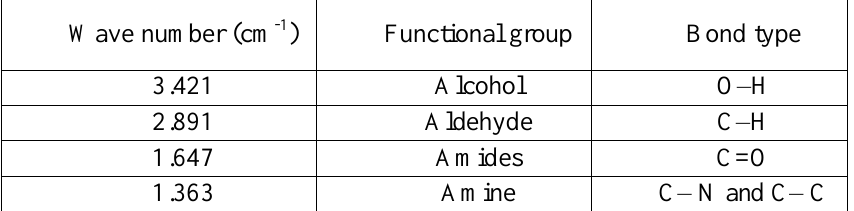
Table 1 . The functional groups present in the FTIR analysis for